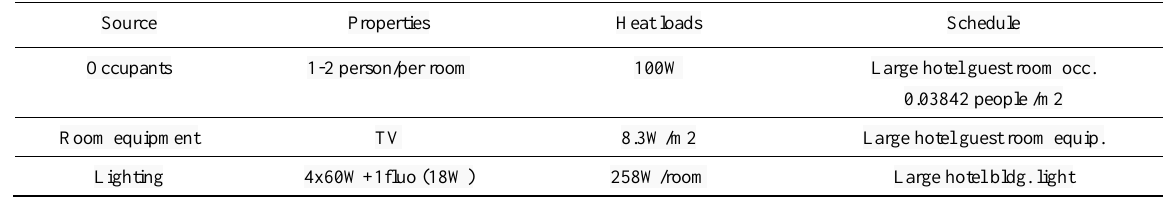
Table 2. Internal heat loads-current